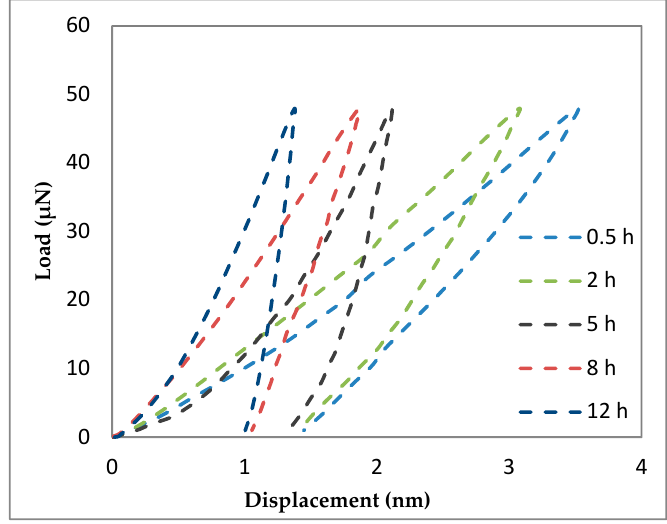
Figure 11. Load–displacement curves of Al-5Al 2 O 3 nanocomposite at different milling time.